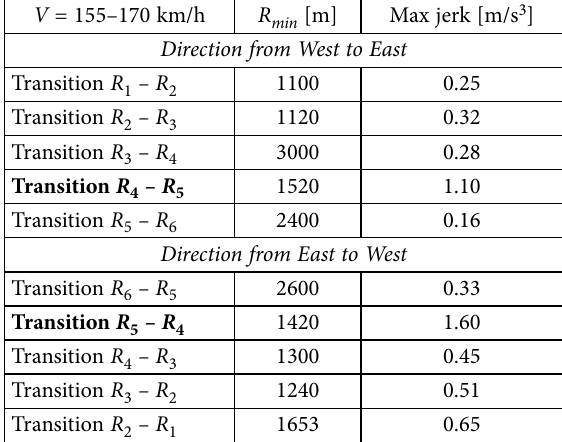
Table 3. Recorded data on transitions between curves of analysed